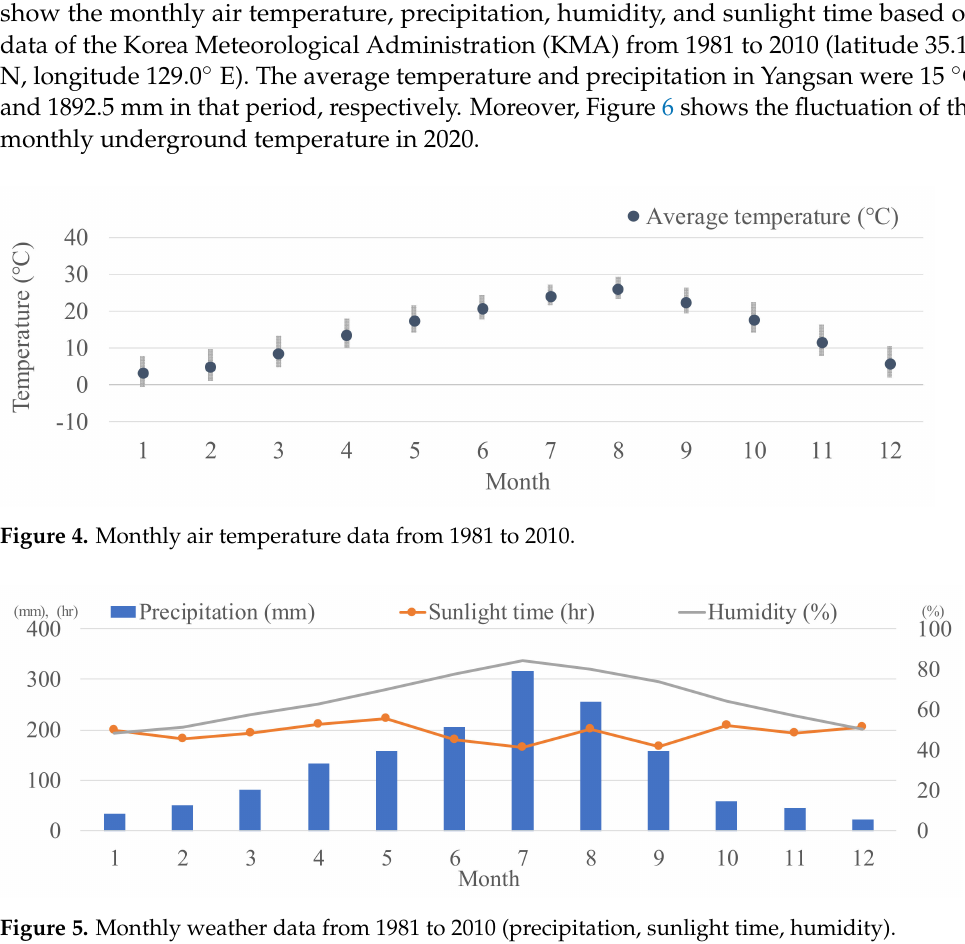
Figure 5. Monthly weather data from 1981 to 2010 (precipitation, sunlight time,